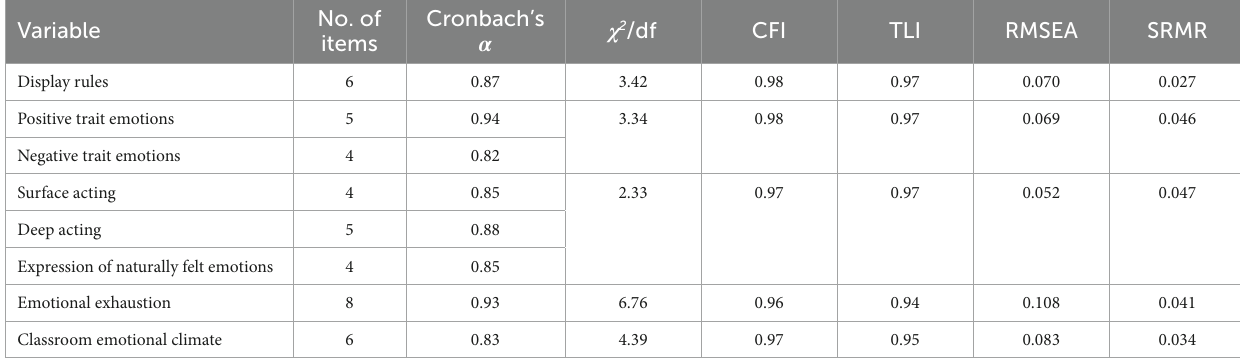
TABLE 1 Latent variables, descriptive statistics, and